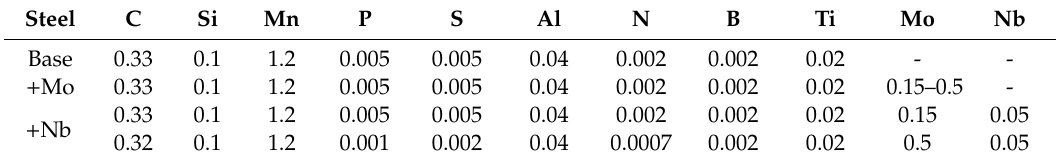
Table 1. Chemical composition (mass percent) of experimental 2000 MPa press hardening